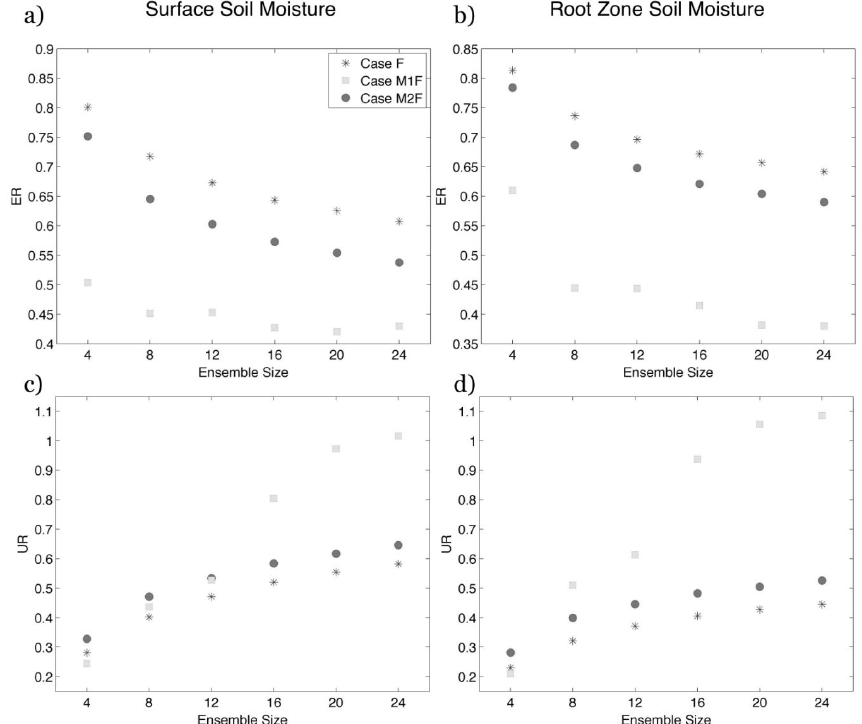
Fig. 10. Exceedance ratios (a, b) and uncertainty ratios (c, d) as function of the ensemble size for surface soil moisture (a, c) and root zone soil moisture (b, d).